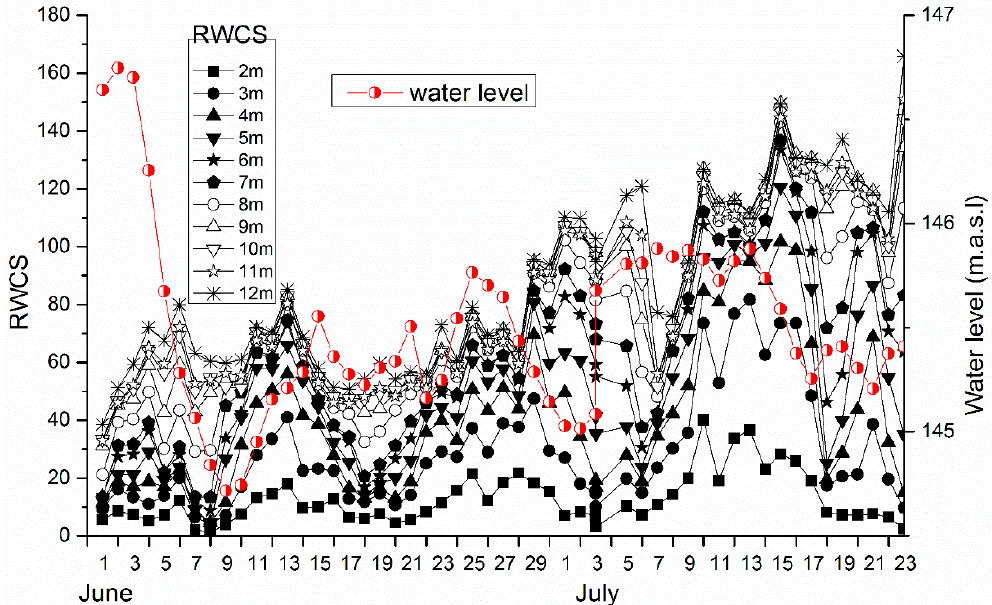
Figure 4. Fluctuations of the daily average relative water column stability (RWCS) of different water columns (2-m water column to 12-m water column, 1-m intervals) in Xiangxi Bay, and the water level (m above sea level, m a.s.l.) variations in Three Gorges Reservoir from 1 June to 23 July 2008. The TN content ranged from 1.14 to 2.30 mg/L, and TP ranged from 0.022 to 0.125 mg/L (Figure 5). TP showed a temporal pattern of “high-low-high-low”, with an evident decrease at the end of June and July, which caused fluctuations in the TN/TP ratio.